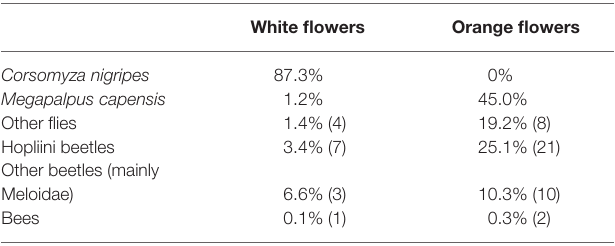
TABLE 1 | Proportion of total visits contributed to focal white and orange daisies by the main groups of insect pollinators. White flowers